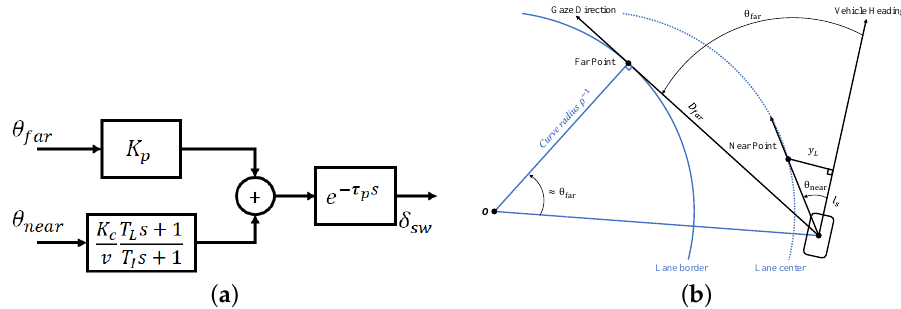
Figure 4. ( a ) Two-point visual model and ( b ) calculation of far-point and near-point angles.